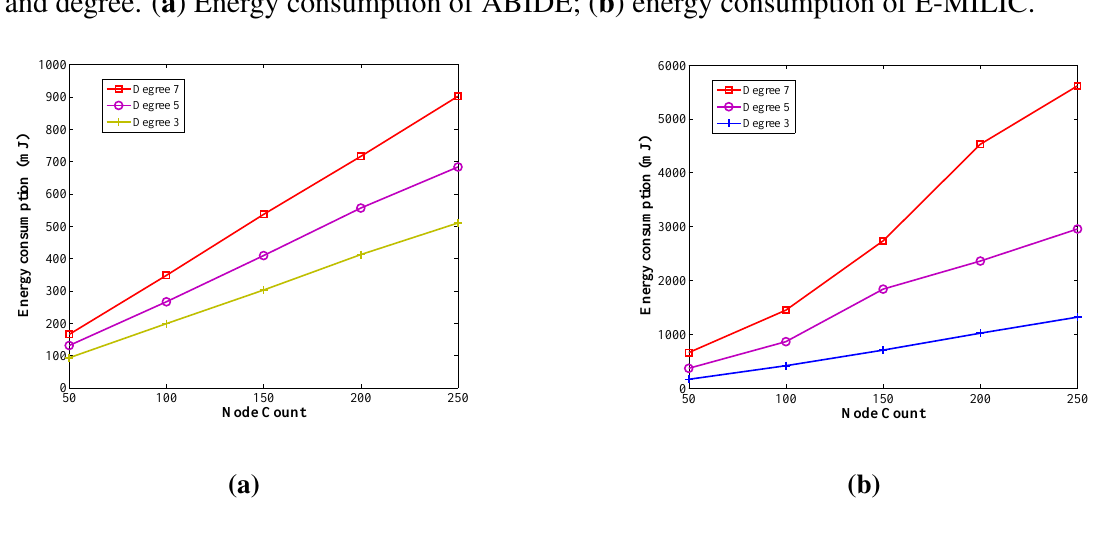
Figure 16. Energy consumption of the ABIDE and E-MILIC algorithms against node count and degree. ( a ) Energy consumption of ABIDE; ( b ) energy consumption of E-MILIC.